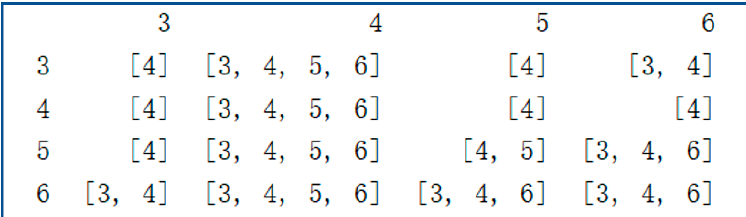
Figure 6. Lower left (running result of Python).